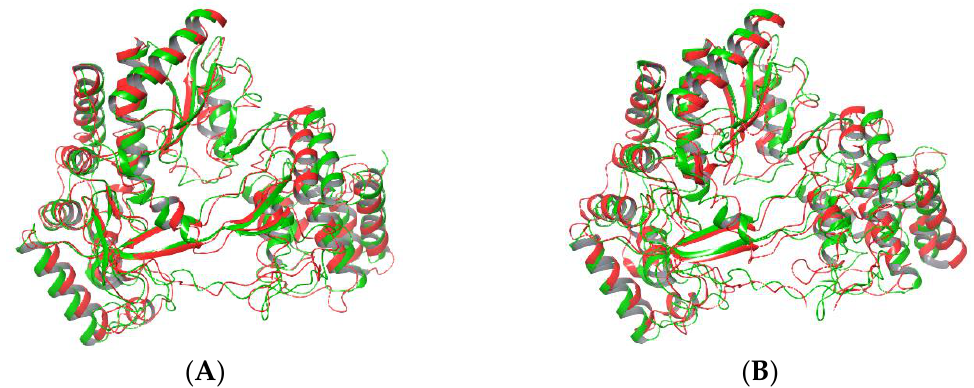
Figure 4. Comparison of protein structure between WT (green) and T179A (red) ( A ) WT vs. T179A, RMSD = 2.76 Å and M289L (red) ( B ) WT vs. M289L, RMSD = 3.95 Å .